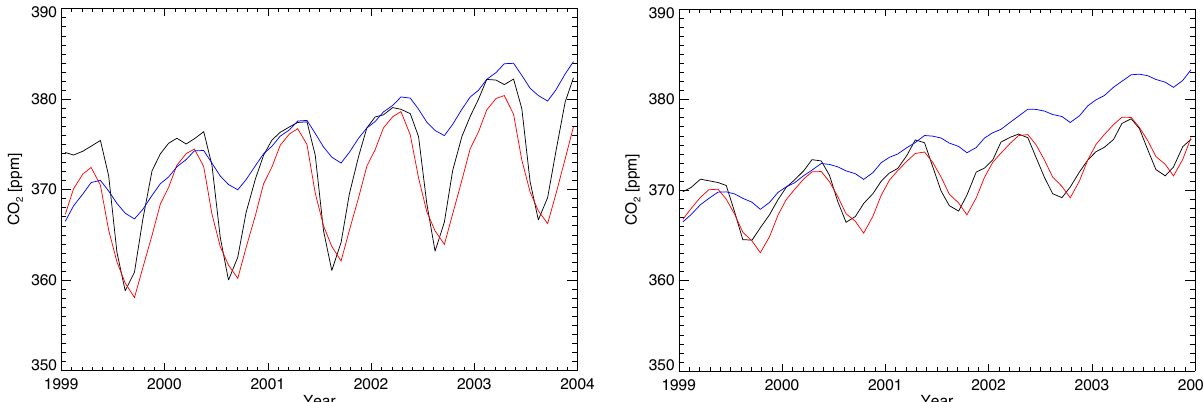
Fig. 4. Atmospheric CO 2 at Point Barrow (left hand panel) and Iza˜na (right hand panel) in ppm: observations (black), prior (blue), and posterior (red).